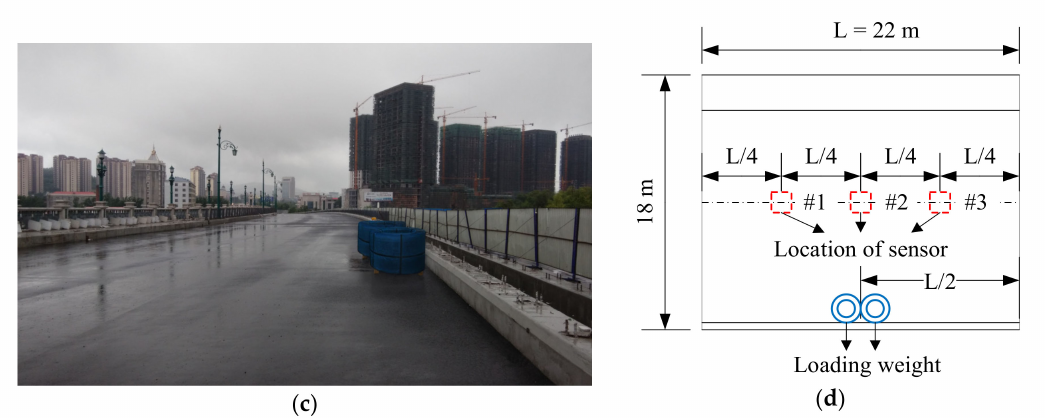
Figure 12. Photographs and placement of the steel weights and accelerometers for the actual beam bridge: ( a ) photograph of the bridge loaded with one steel weight; ( b ) placement of one steel weight and accelerometers; ( c ) photograph of the bridge loaded with two steel weights, and ( d ) placement of two steel weight and accelerometers.